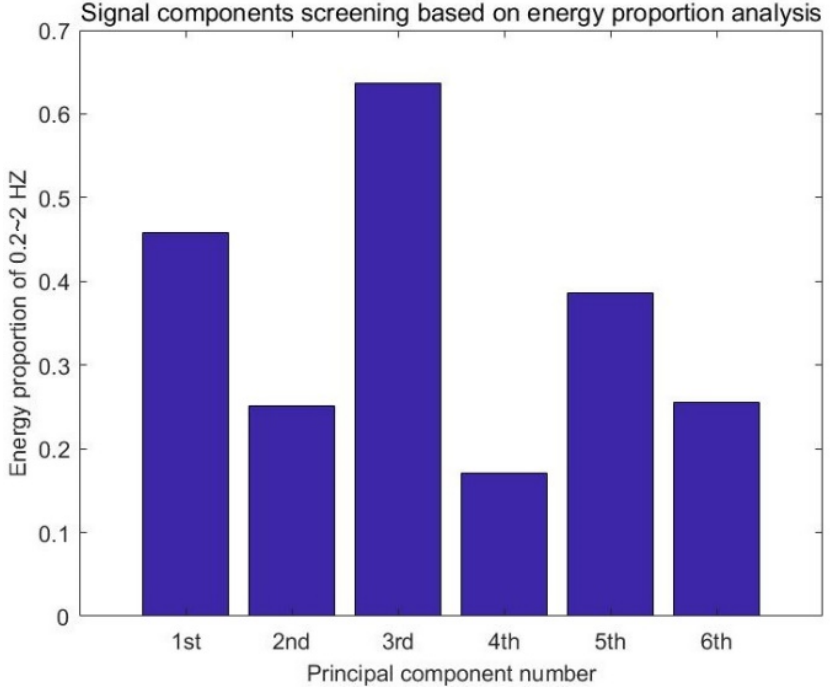
Figure 11. Energy proportion diagram of vital signs frequency band.